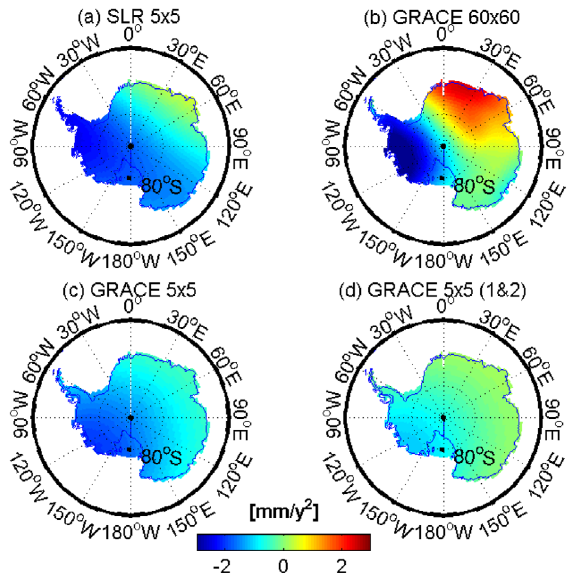
Figure 3. The quadratic term of ice-sheet mass variations over Antarctica from (a) SLR 5×5, (b) GRACE 60×60, (c) GRACE 5×5, and (d) GRACE 5×5 (1&2).